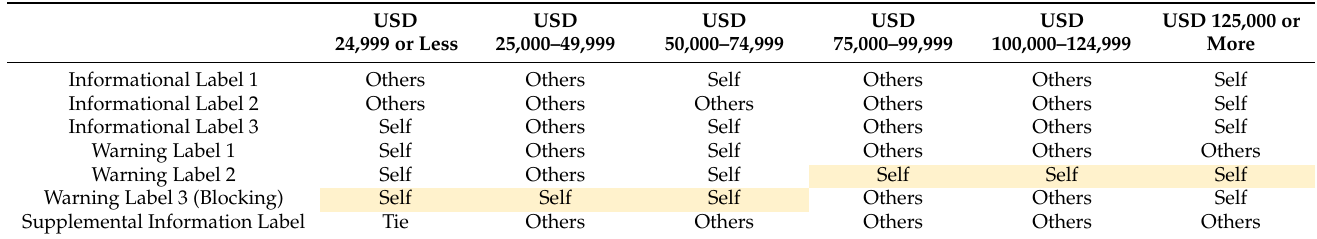
Table 7. Do respondents see labels as more valuable to self or others, by income level.